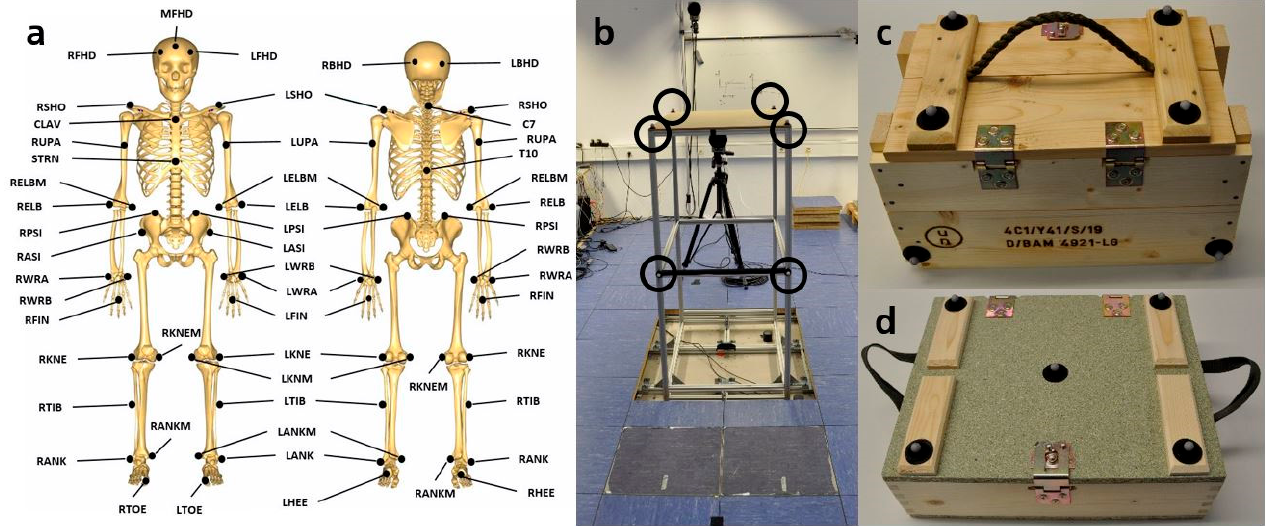
Figure 1. ( a ) Subject marker positions for optical motion markers. ( b ) Replicated loading platform with attached markers, highlighted with black circles. ( c ) Box A with attached markers and handle on top. ( d ) Box B with attached markers and two lateral handles.